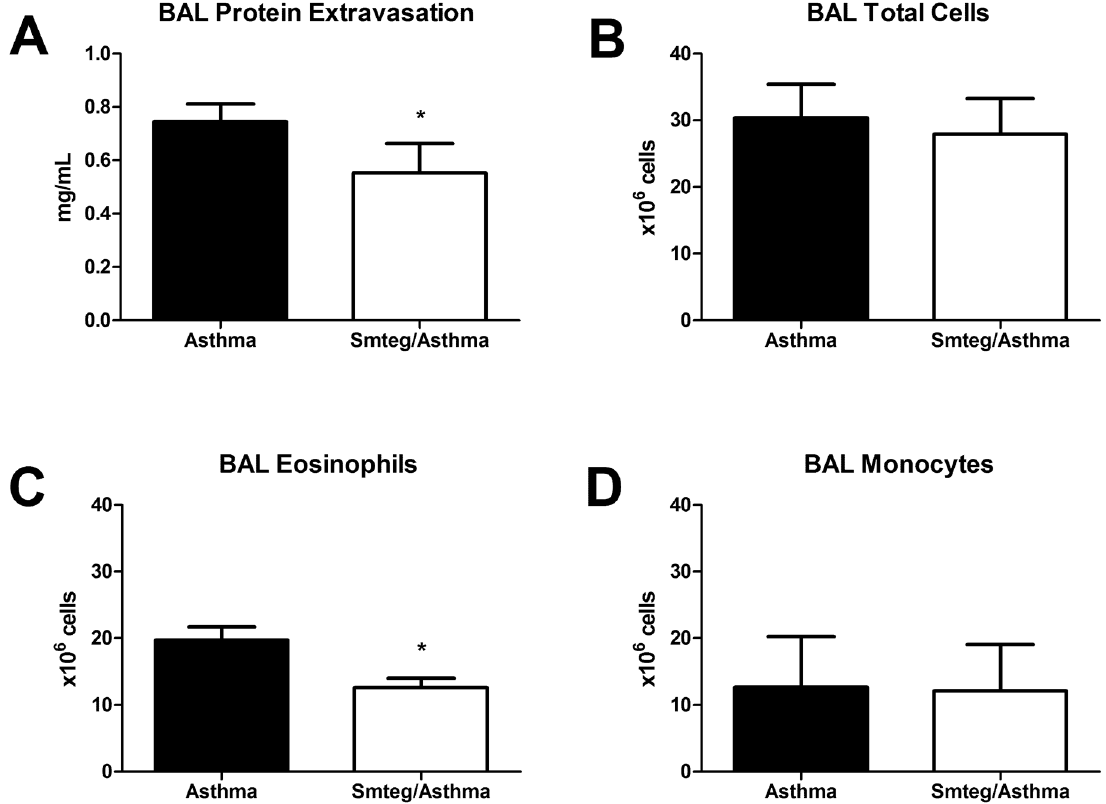
Fig 2. Reduction in airway inflammation induced by Smteg treatment. ( A ) Proteins extravasation, ( B ) the numbers of total cells, ( C ) eosinophils and ( D ) monocytes were quantified in BAL. The treatment with Smteg reduced significantly the protein extravasation and eosinophil counting compared to Asthma group. * p < 0,05; Student's t test. Data are representative of 2 independent experiments. Results are presented as mean ± SD.